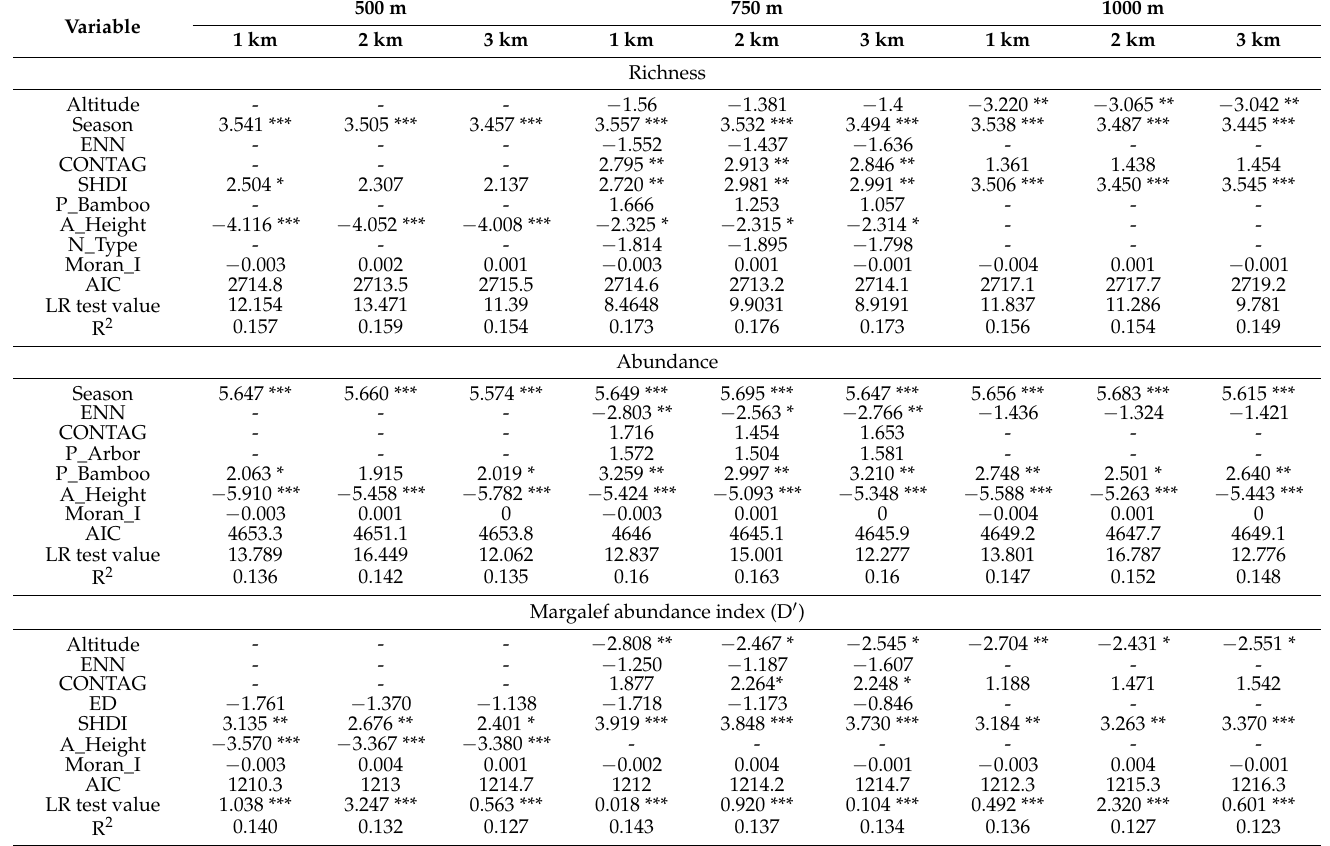
Table 4. The z cores of SLM for species richness and abundance of birds in three spatial scales (500 m, 750 m and 1000 m). The lag distances are 1 km, 2 km and 3 km. (* Pr(>|z|) < 0.05, ** Pr(>|z|) < 0.01, *** Pr(>|z|) < 0.001). SHDI is Shannon–Wiener landscape diversity index; A_Height is the average canopy height; P_Bamboo is percentage of bamboo; ED is edge density index; ENN is Euclidean nearest-neighbor distance index; CONTAG is contagion index; N_Types is the number of land cover types. LR test is likelihood ratio